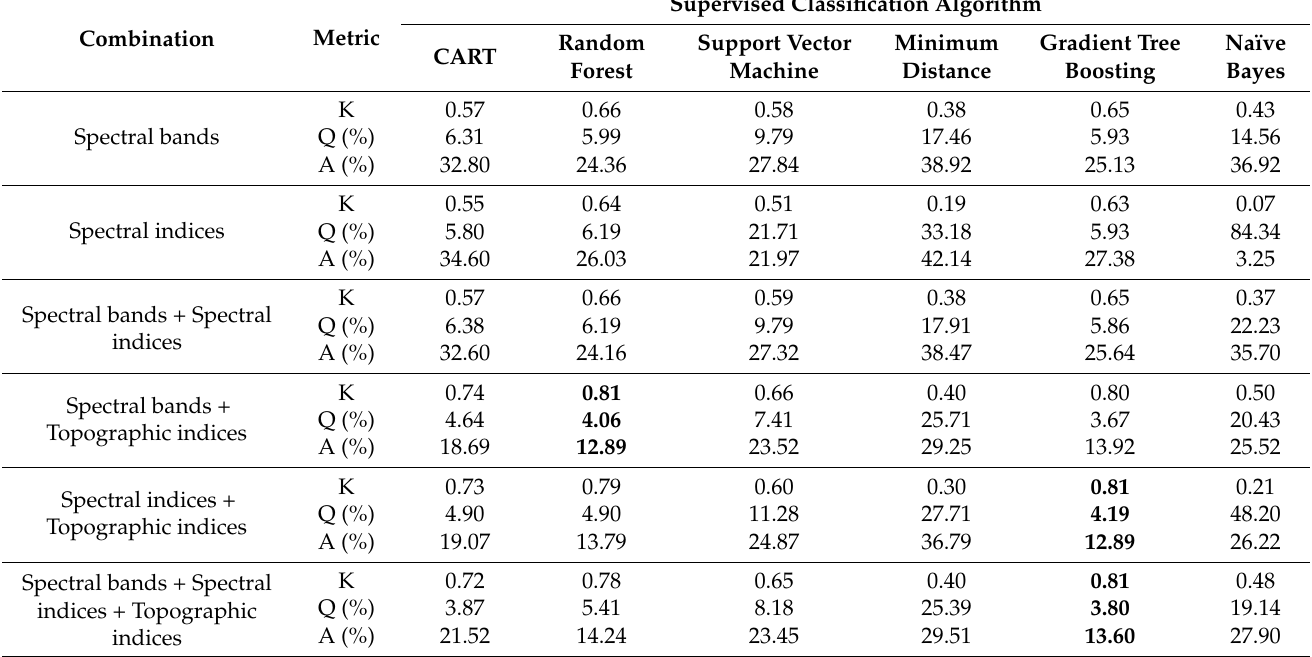
Table 4. Accuracy assessment of land cover classification using machine learning algorithms from Google Earth Engine (GEE).